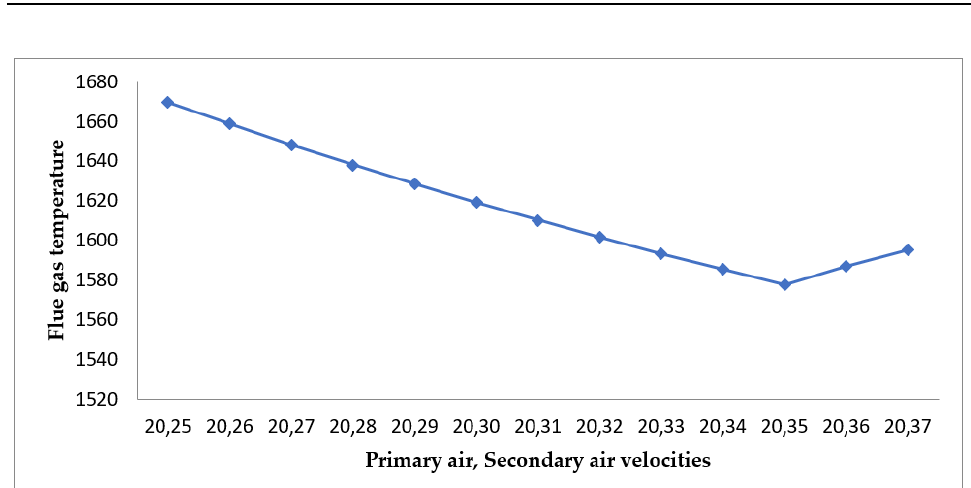
Figure 24. Primary air, Secondary air VS Flue gas temperature generated from Python.